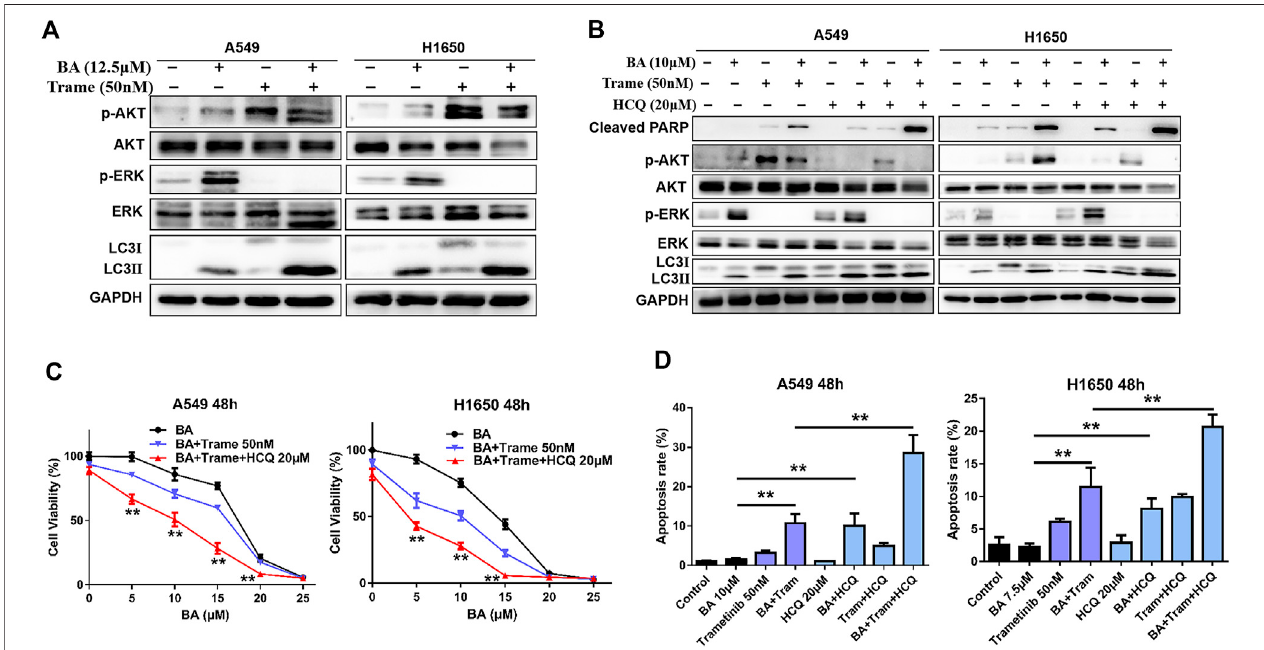
FIGURE7| Triple-drugtherapywasthemosteffectiveforlungcancercells invitro . (A) A549andH1650cellsweretreatedwith12.5 μ MBA,50 nMtrametinib,orin combinationfor48 h,andthelevelsofAKT,p-AKT,LC3,cleavedPARP,ERK,andp-ERK1/2weredeterminedbyWesternblots. (B) A549andH1650cellsweretreated withindicatedchemicalsaloneorincombinationfor48 h,andthelevelsofAKT,p-AKT,LC3,cleavedPARP,ERK,andp-ERK1/2weredeterminedbyWesternblots. (C) A549 and H1650 cells were treated with indicated chemicals alone, or in combination for 48 h, and cell viability was measured by the MTT assay. (D) A549 and H1650 cells were treated with indicated chemicals alone, or in combination for 48 h, and cell apoptosis was detected using fl ow cytometry. ** p <